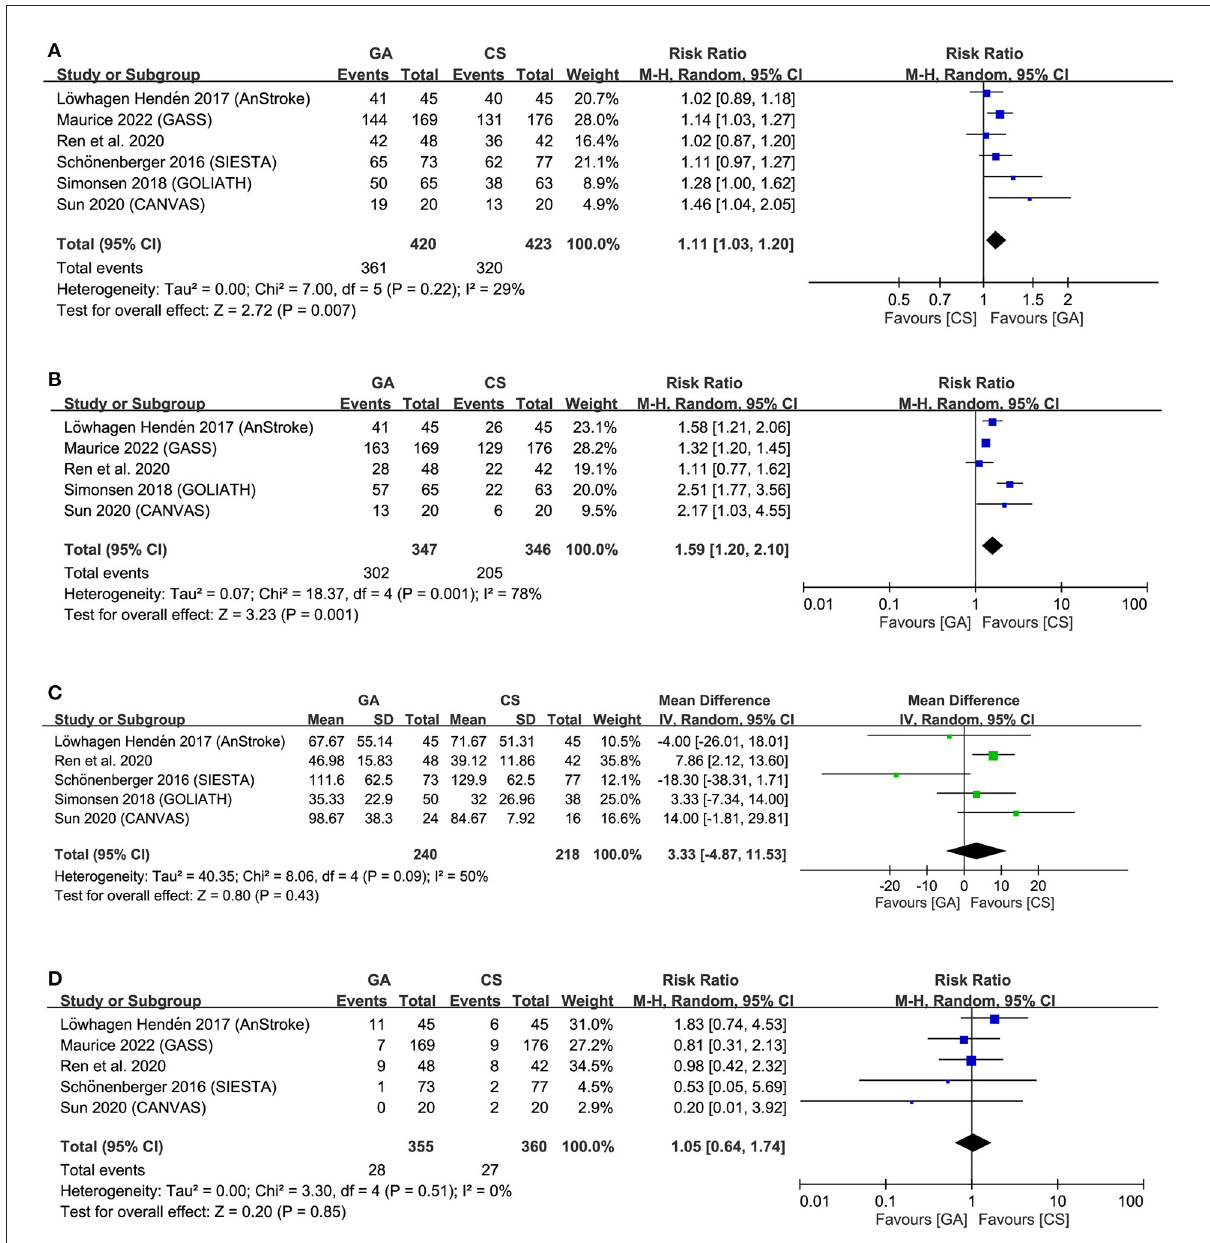
FIGURE4 Forest plot comparing (A) successful recanalization rate, (B) hypotension risk, (C) duration from puncture to reperfusion, and (D) risk of procedure-related complications between general anesthesia (GA) and conscious sedation (CS) groups. IV, inverse variance; CI, confidence interval; M-H,